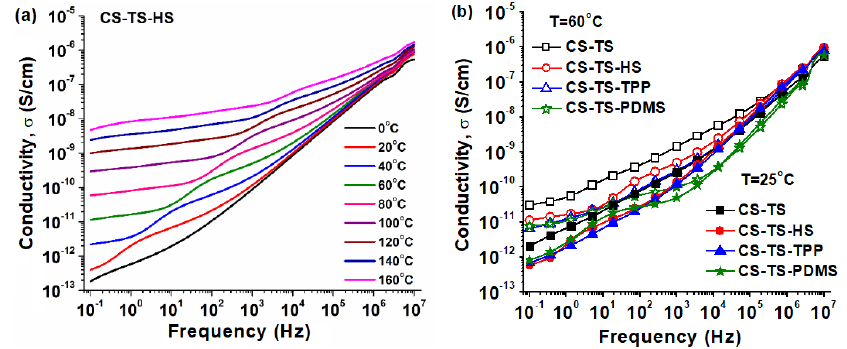
Figure 7. Evolution of the measured conductivity with frequency and temperature for dry membranes: ( a ) CS-TS-HS membrane ( b ) comparison of conductivity behavior of all prepared membranes.